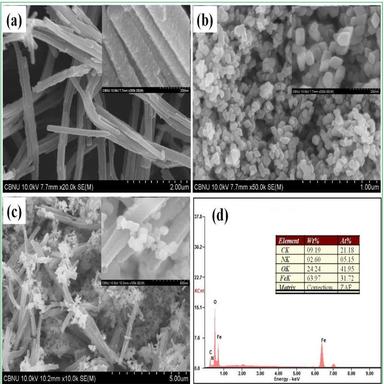
FESEM images of N-CNT (a), bare Fe2O3 (b) and Fe2O3/N-CNT (c), (d) corresponding EDX spectrum of Fe2O3/N-CNTc.